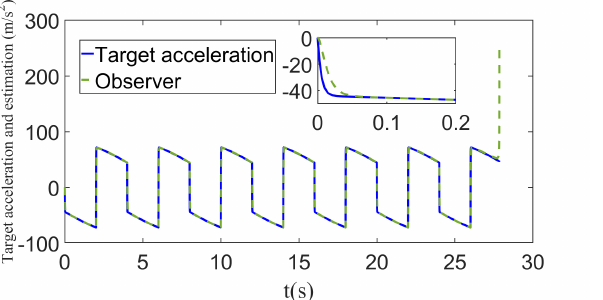
Figure 15. The target’s acceleration a T